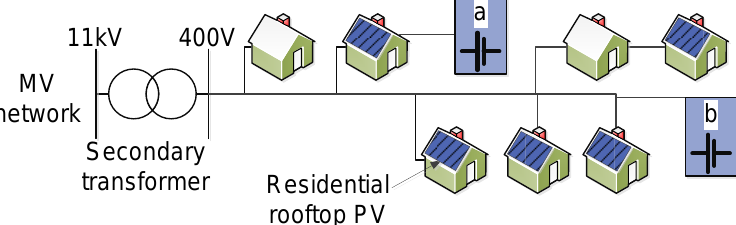
Figure 1. Locations for low voltage (LV) storage showing ( a ) storage in homes owned by customers and ( b ) storage located on the street.